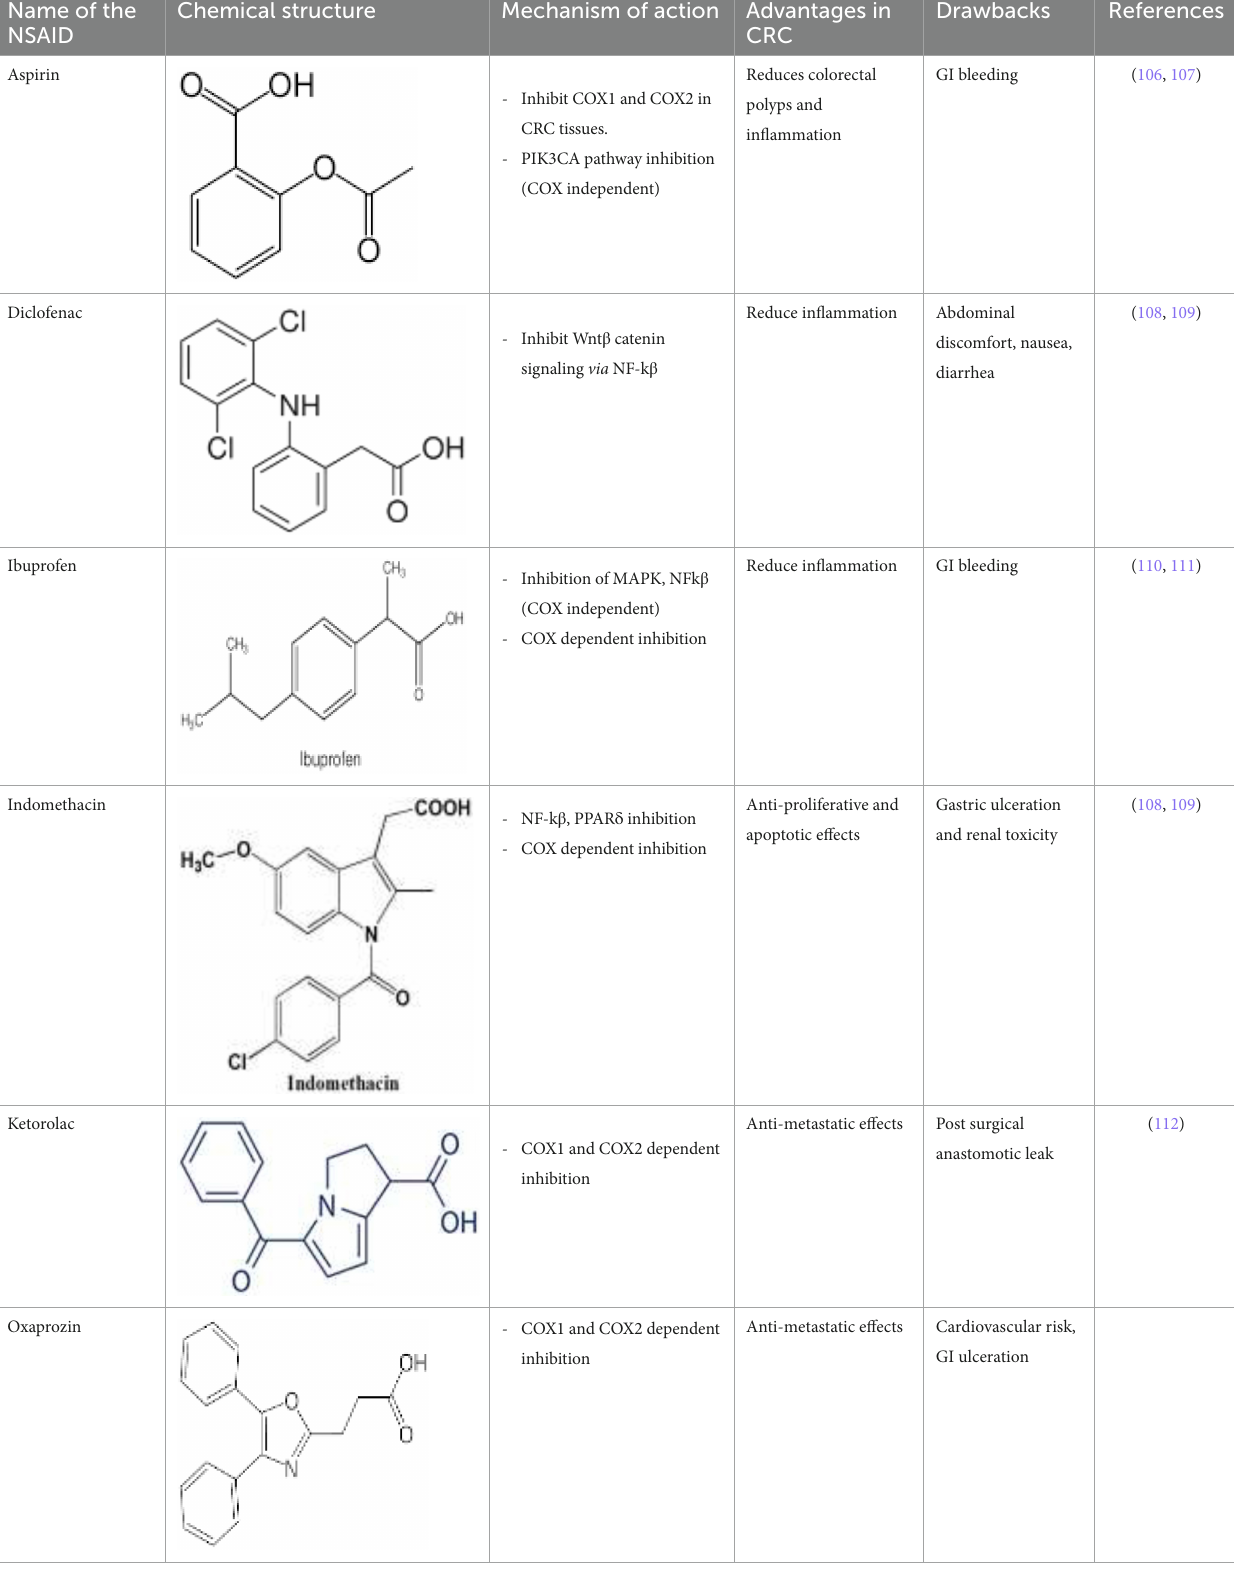
TABLE 3 A systematic representation of mechanism of action of NSAIDs along with their advantages and drawbacks. Name of the